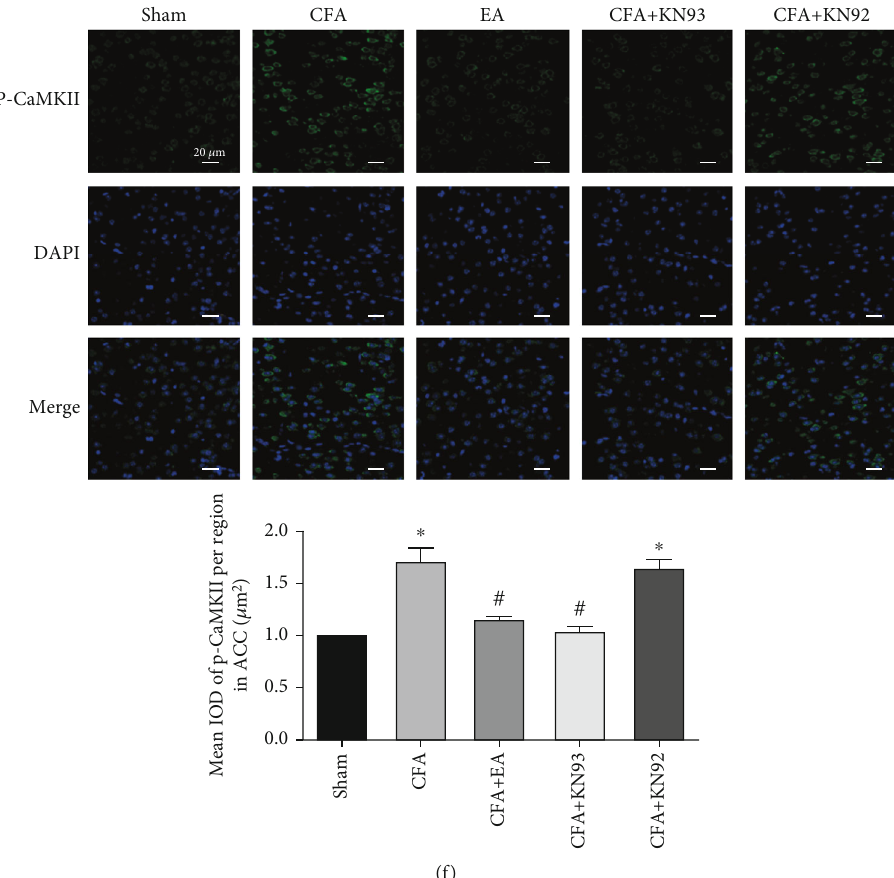
Figure 5: E ff ects of inhibitor on the protein levels of P-CaMKII and P-GluA1. (a) Representative western blot images of P-CaMKII, CaMKII, P-GluA1, and GluA1. (b – d) Statistical analysis of P-CaMKII, CaMKII, P-GluA1, and GluA1. (f) Immuno fl uorescence results and statistical analysis of P-CaMKII. Scale bar = 20 μ m . Results represent the mean ± SEM ( n = 4 /group). ∗ P < 0 : 05 vs. sham group; # P < 0 : 05 vs. CFA group.